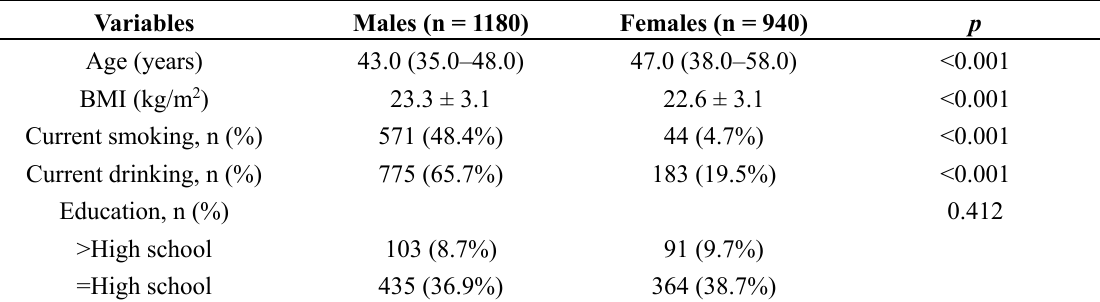
Table 1. Baseline characteristics of the study